Question: Describe this figure in one sentence.
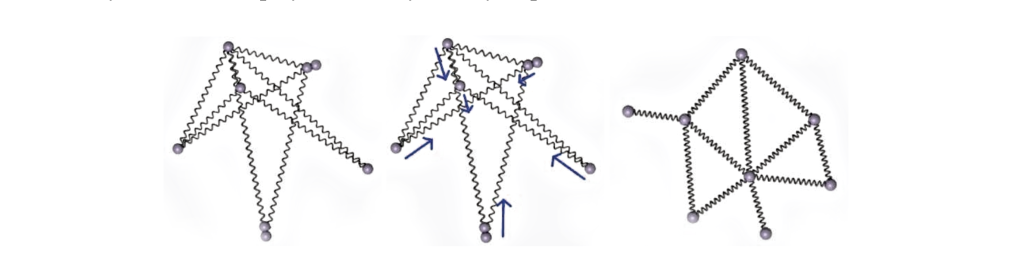
Answer: illustrates the effectiveness of PE constrains. The PE constrains try to make the system stable by minimizing the potential energy. After some iterations, the system will achieve “aesthetically pleasing” layout, which can be captured by two criteria: "all the edge lengths ought to be the same, and the layout should display as much symmetry as possible." Kobourov (2012).